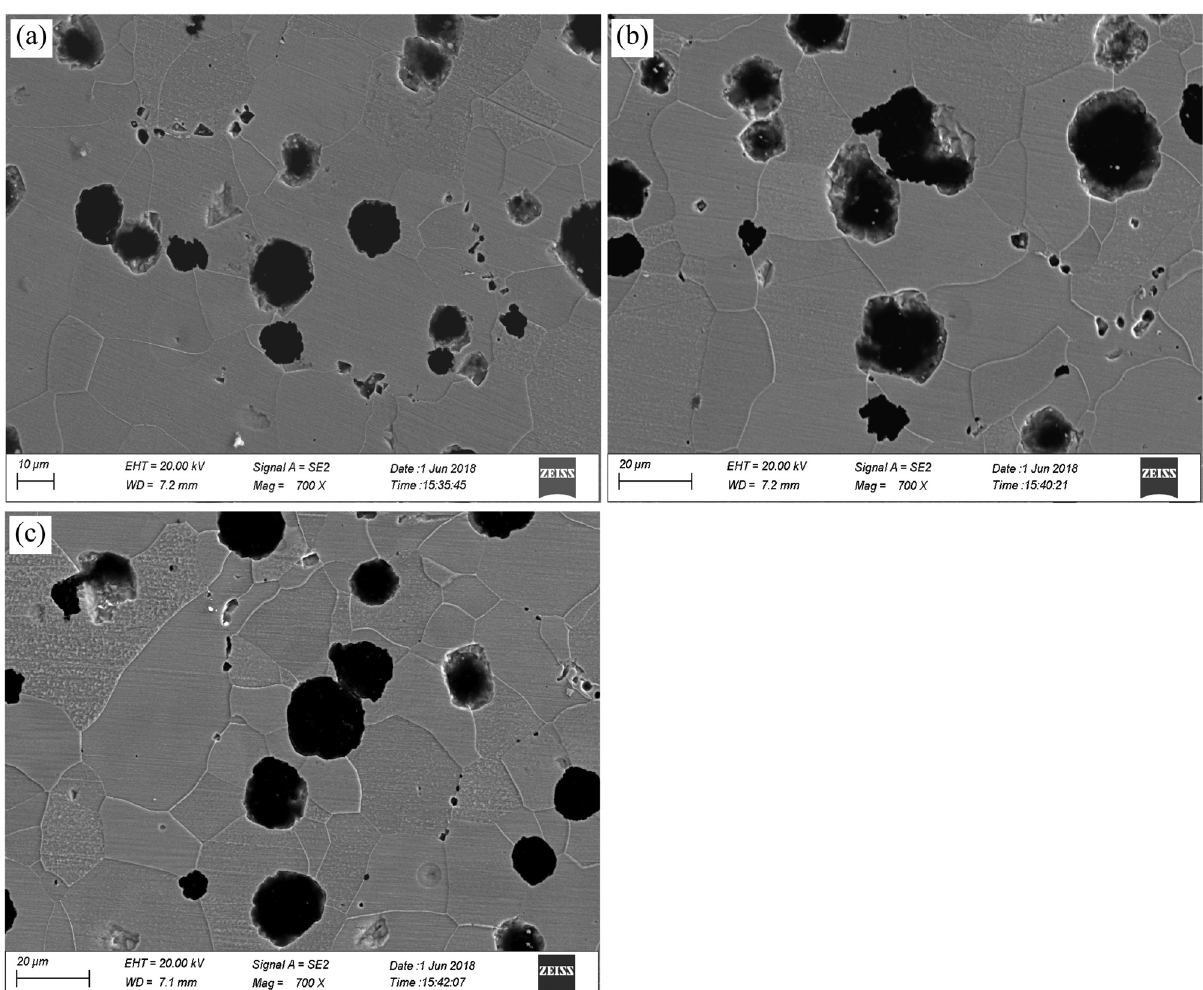
Figure 5: Distribution of the micro - shrinkage porosity of the ingot when φ A is 20 mm: ( a ) center part; ( b ) ⅔ radius away from ingot center; ( c )